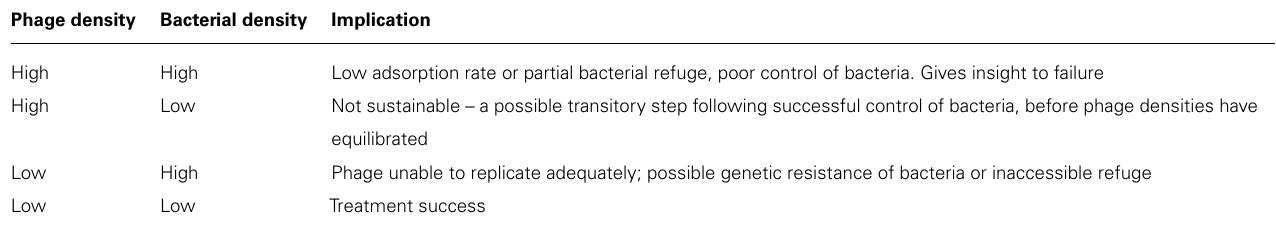
Table 3 | Interpretation of bacterial and phage counts at a single time point after